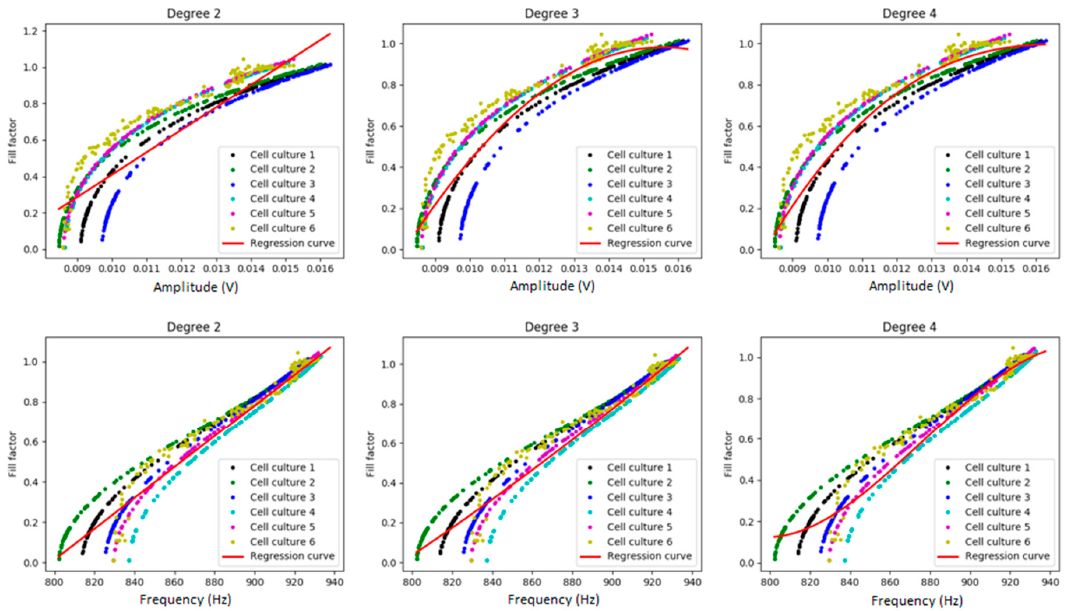
Figure 4. Polynomial regression of fill-factor against frequency (Hz) and amplitude (volts) for myoblasts. We can observe the experimental data obtained for the six different myoblast cell cultures and the regression curve obtained for polynomial regression (red line).